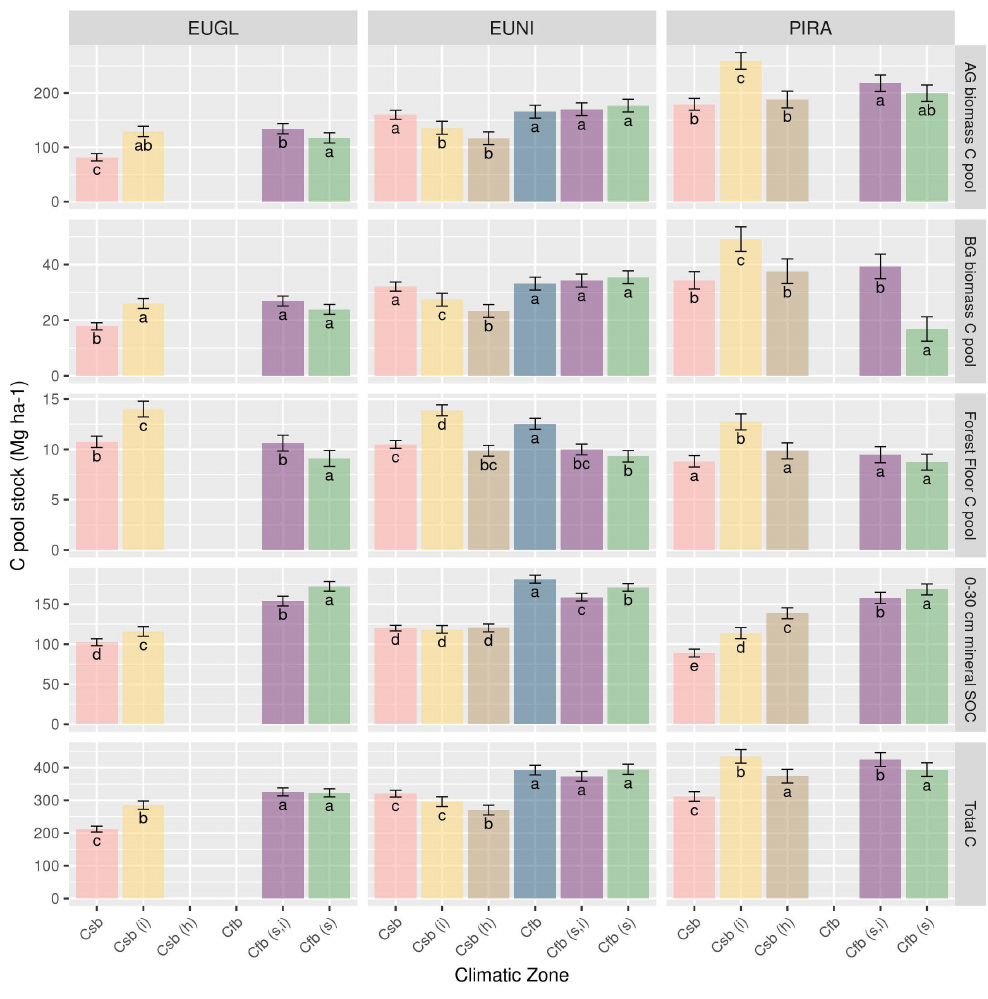
Figure 8. Mean and confidence interval of the mean for the 4 carbon pools (Above-ground (AG) biomass, Below-ground (BG) biomass, forest floor and 0–30 mineral soil organic carbon (SOC) C pools) and the total C for Eucalyptus globulus (EUGL), Eucalyptus nitens (EUNI) and Pinus radiata (PIRA) at rotation age (10–14 years-old for EUGL and EUNI, 20–24 years-old for PIRA) at the climatic zones evaluated: Mediterranean warm/cool summer climate (Csb), Mediterranean warm/cool summer climate from highlands (Csb(h)) and Mediterranean warm/cool summer climate with a more pronounced coastal influence (Csb(i)), Ocean climate (Cfb), Ocean climate with a dry summer (Cfb(s)), and Ocean climate with a more pronounced coastal influence and dry summer (Cfb(s,i)). Means denoted by a different letter indicate significant differences for p <